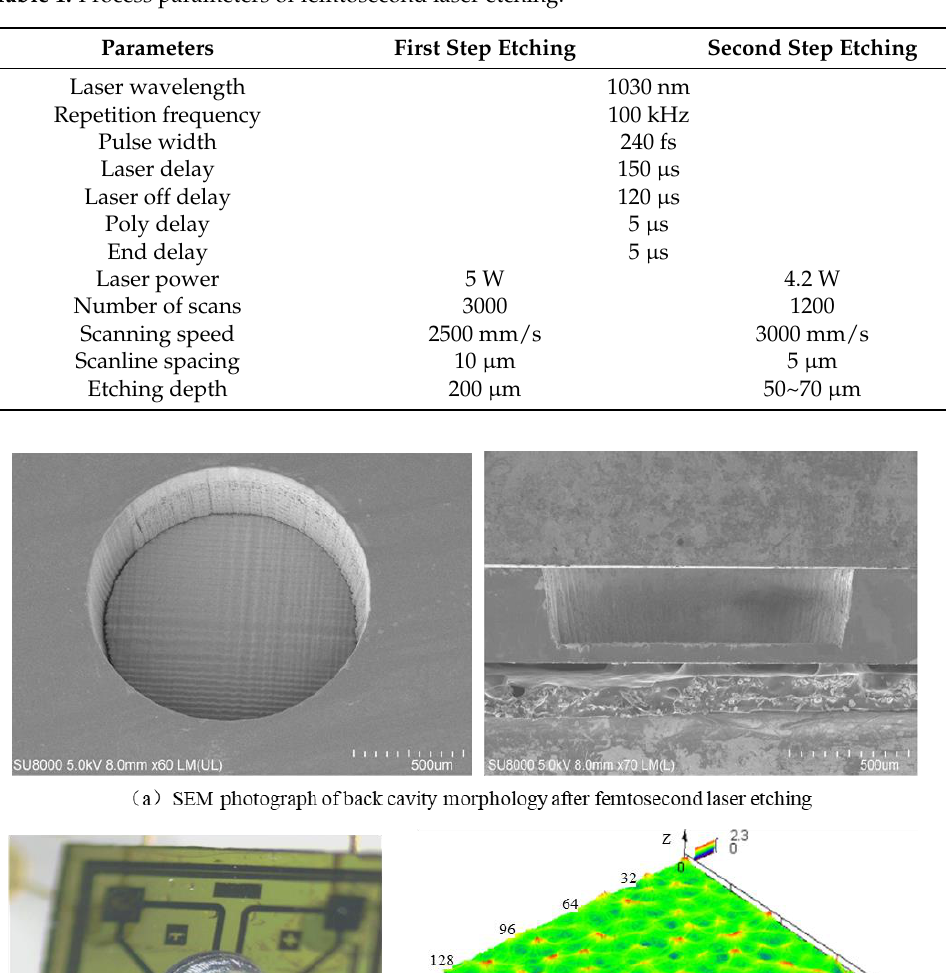
Figure 9. Gold wire bonding package of the SiC pressure sensor.